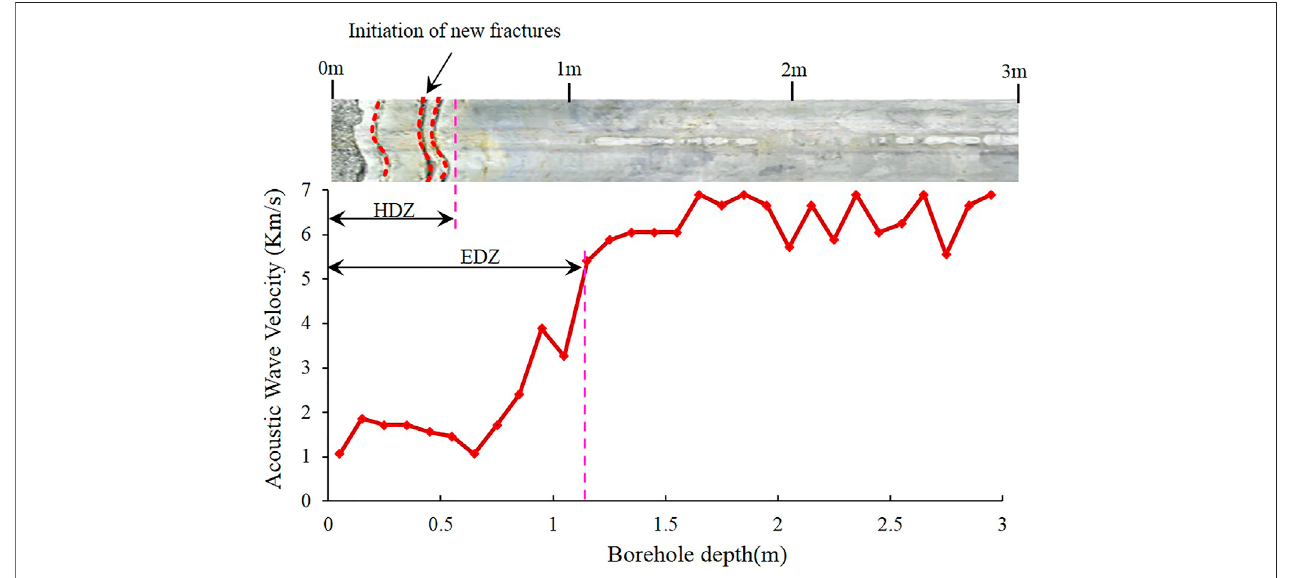
FIGURE 8 | Test result in borehole T7-4.